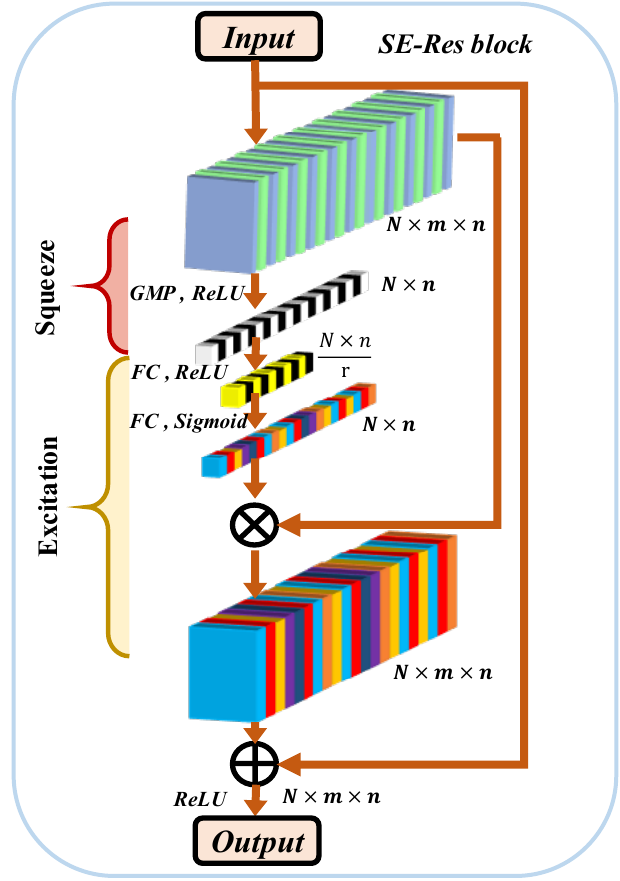
Figure 2. SE-Res Figure 2. SE-Res block.